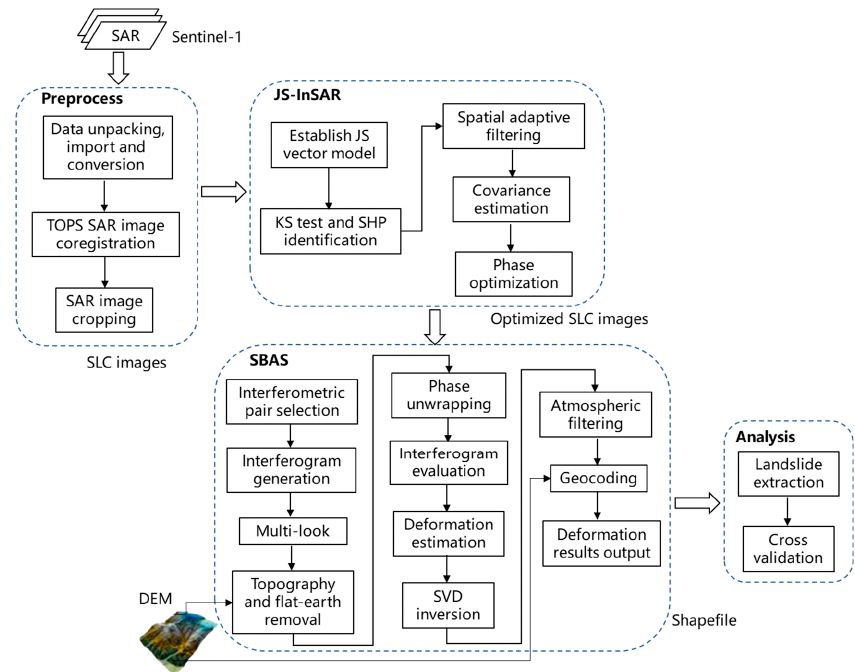
Figure 3. The processing chain of the proposed method.